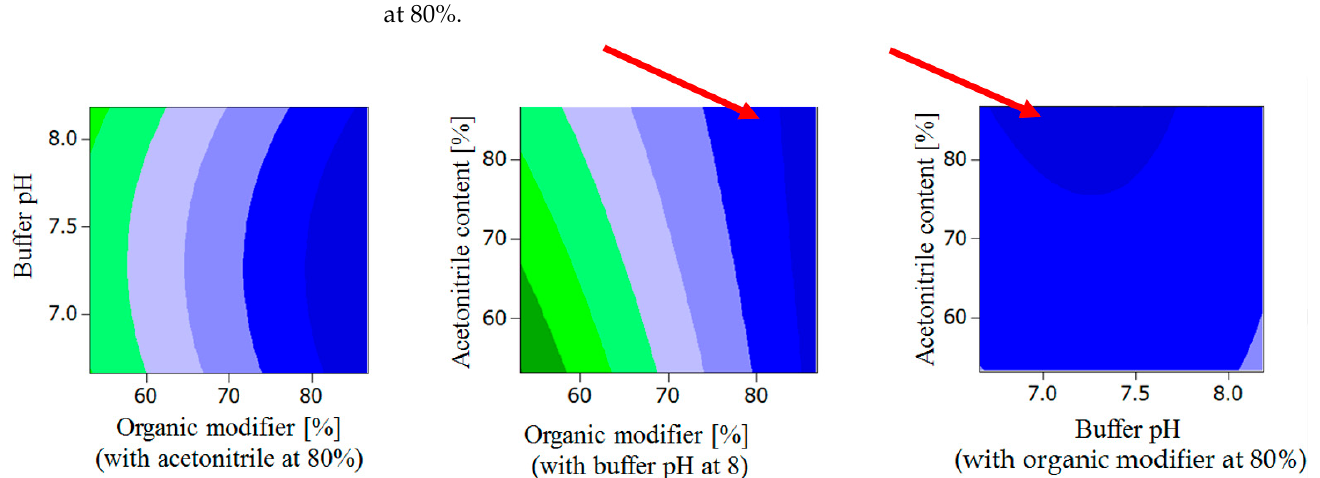
Figure 3. Response surface contour plots for R s2 : the dark green plot regions represent those of the highest R s . The red arrows indicate the “global solution” predicting the optimum chromatographic conditions for highest R s (see Section 2.1.5).